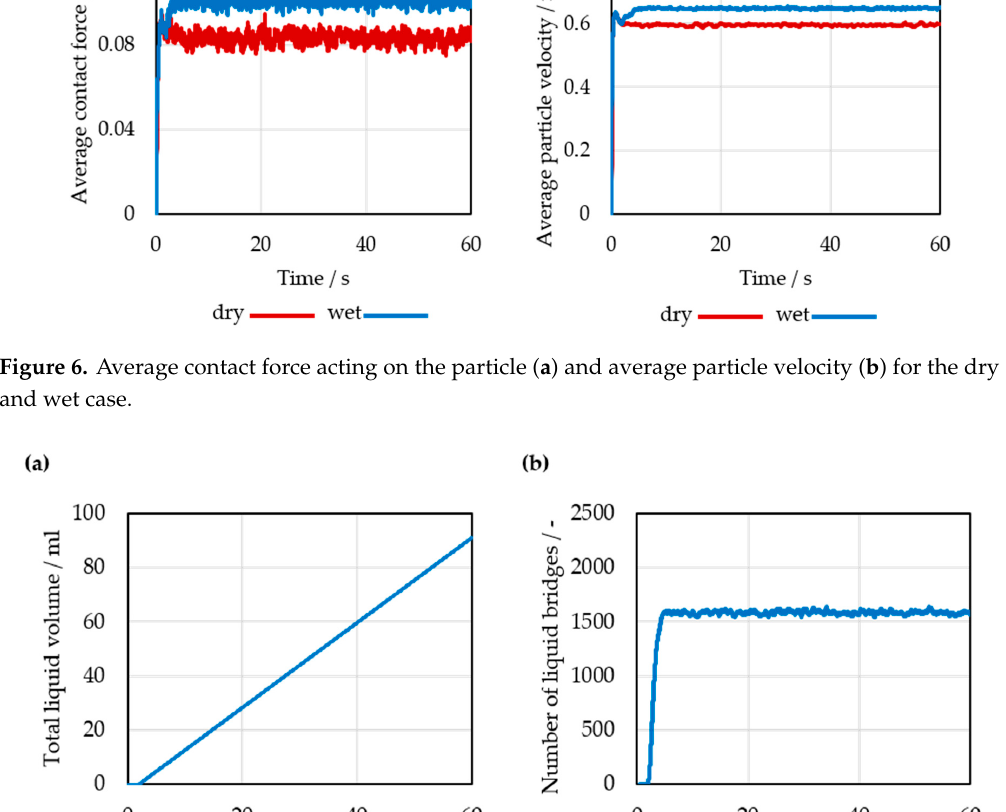
Figure 7. Total liquid volume of the particles over time ( a ) and number of liquid bridges over time ( b ).